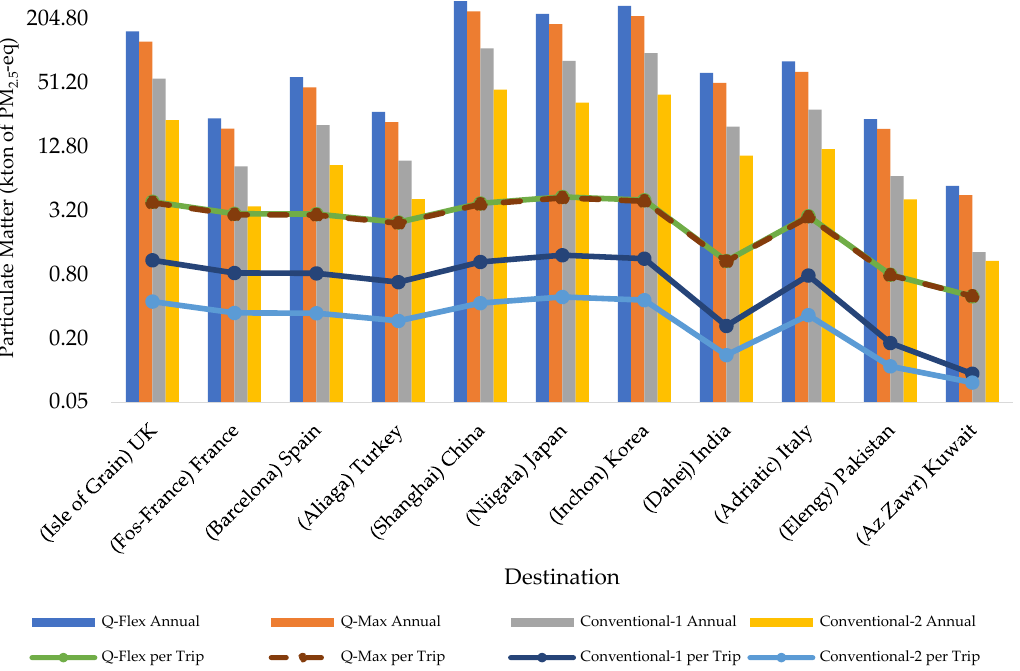
Figure 6. PM 2.5 -eq emission results for the roundtrip and annual.